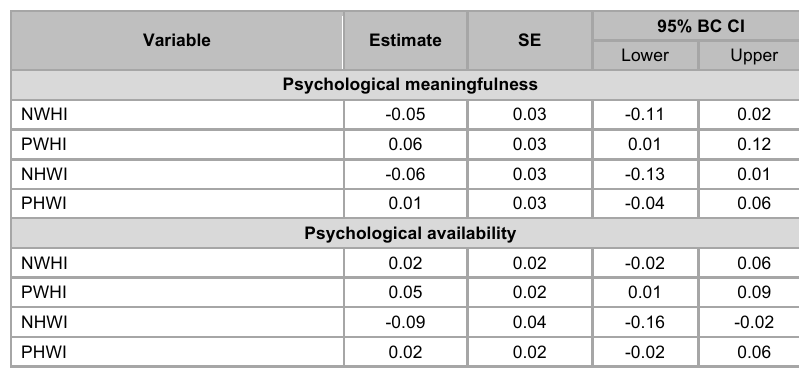
Indirect effects of work-home/home-work